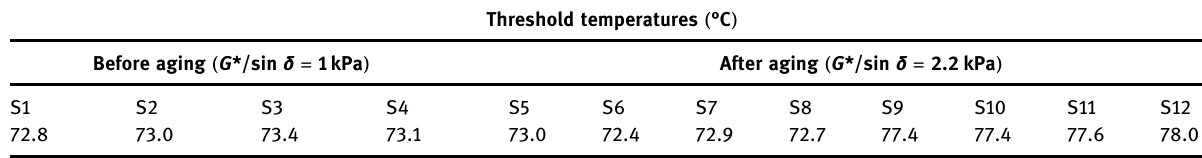
Table 1: Threshold temperatures of asphalt binder before and after aging in various concentrations ( S1 – S12 ) of